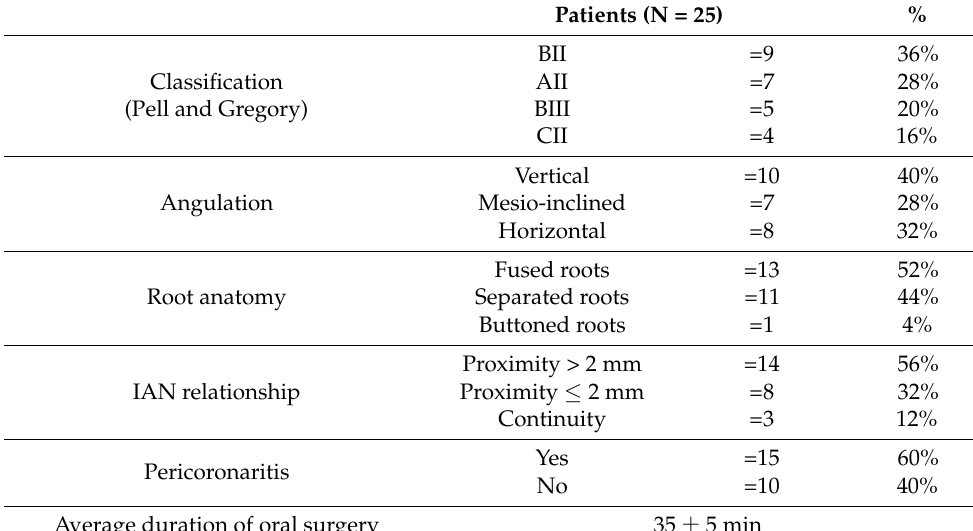
Table 3. Characteristics of lower impacted third molars